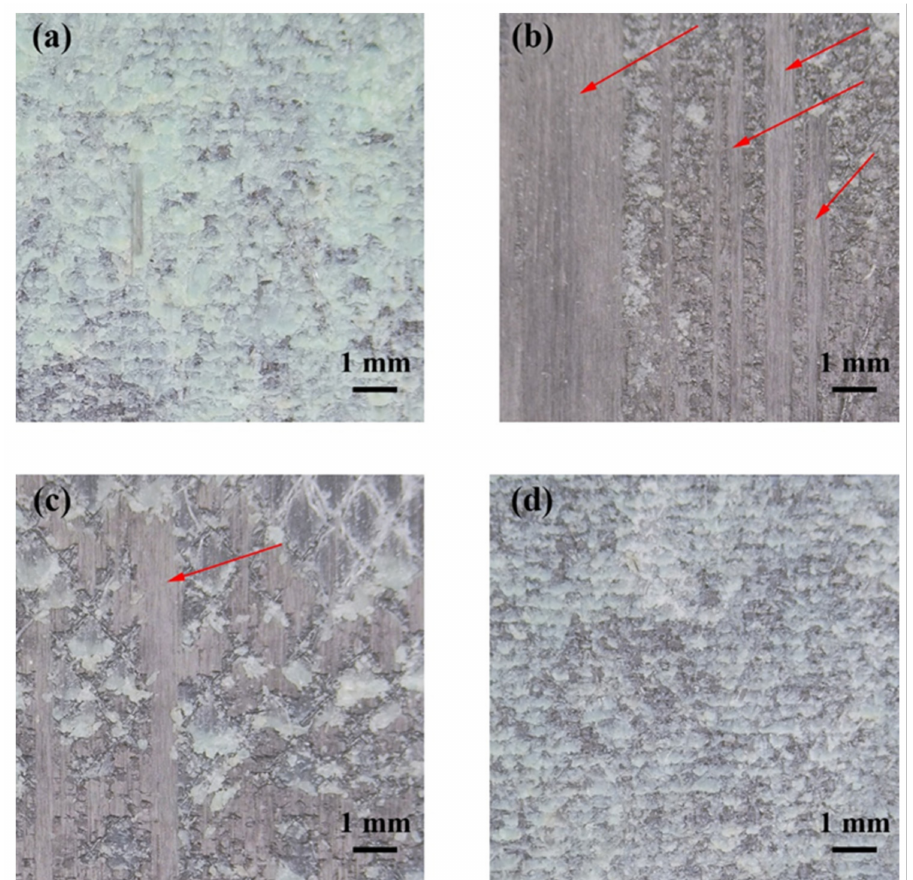
Figure 9. Failure modes of shear test samples with different surface treatment: ( a , b ) sanding, ( c ) dry peel ply, and ( d ) wet peel